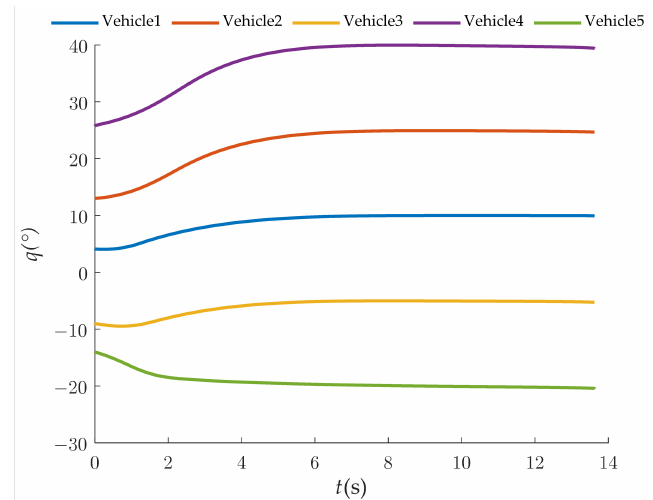
Figure 6. Attack angles of the LOS.